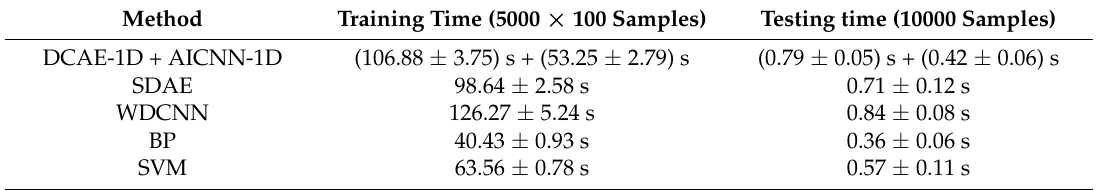
Table 10. Computational time of the proposed models and the existing